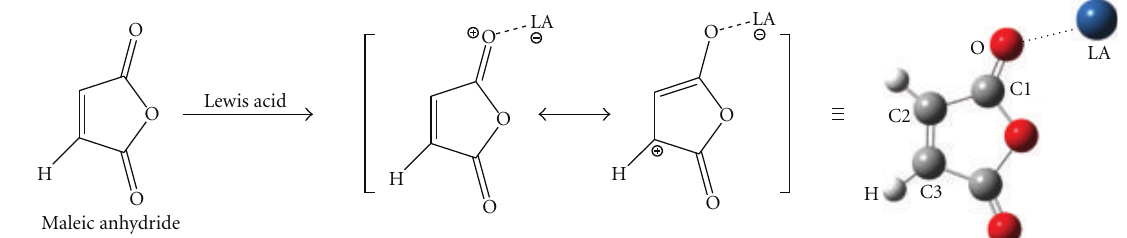
Figure 25: Chemical shift perturbation of β -H in maleic anhydride upon exposure to a Lewis acid (LA) [45].